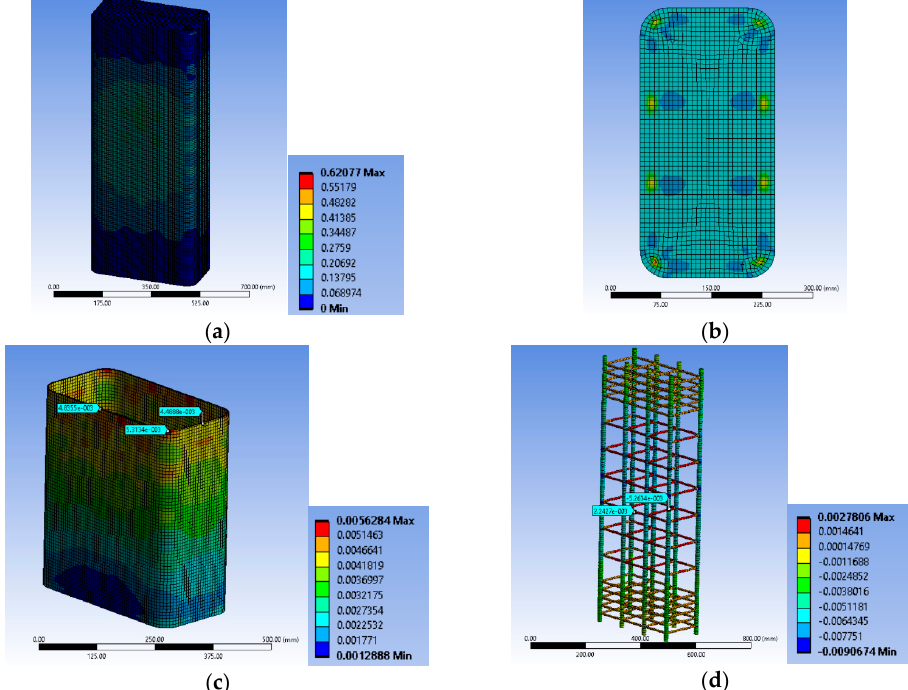
Figure 14. Variation of concrete damage ( a ) at the ultimate condition condition; ( b ) at the level of the stirrup; ( c ) CFRP strain and characteristic values at the ultimate condition at the level of the stirrup and ( d ) ε stirrup_max , ε long_mid and ε long_min for specimen R2.0H2CL3.